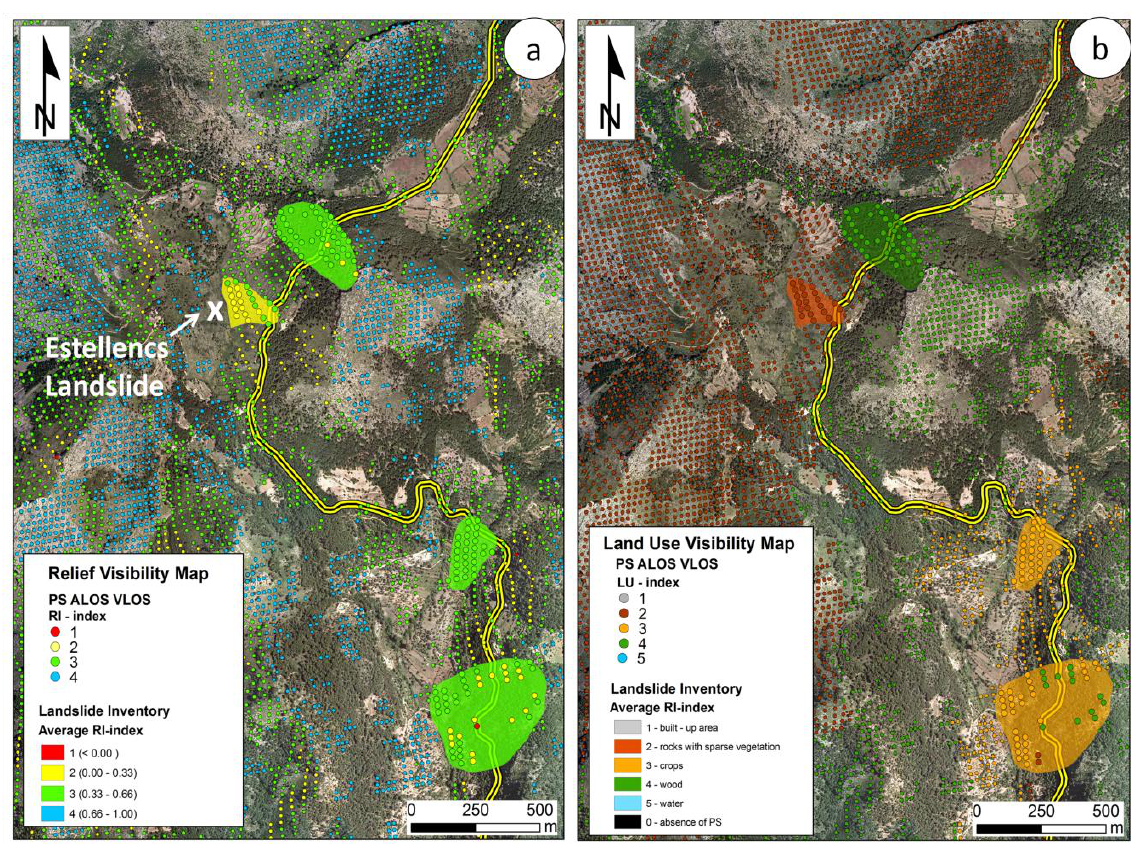
Figure 7. Landslide activity maps: ( a ) Visibility map based on R-index; ( b ) Visibility map based on